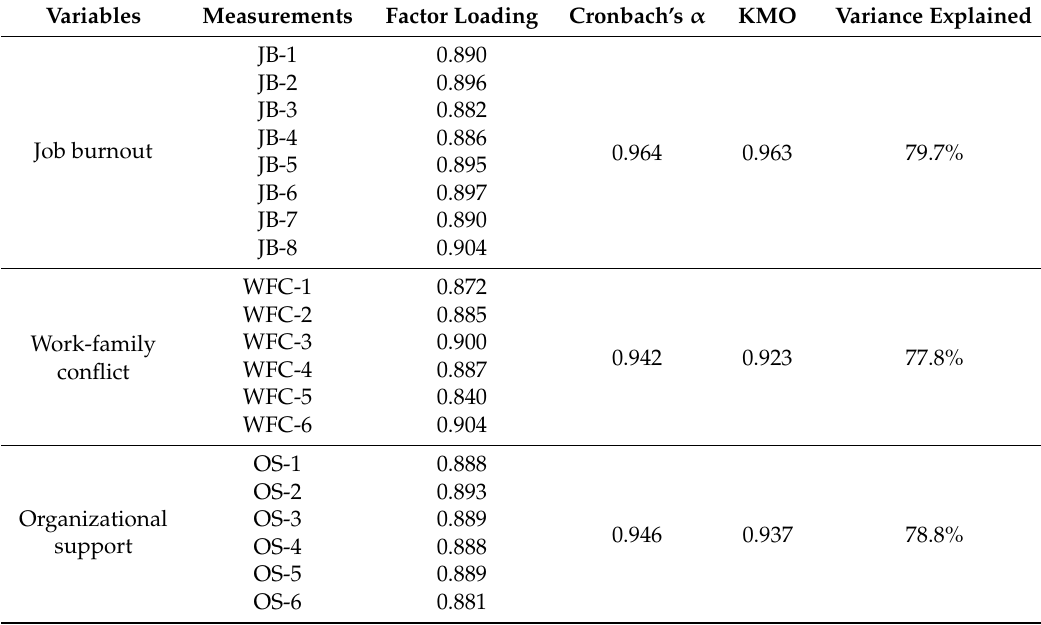
Table 3. Results of validity and